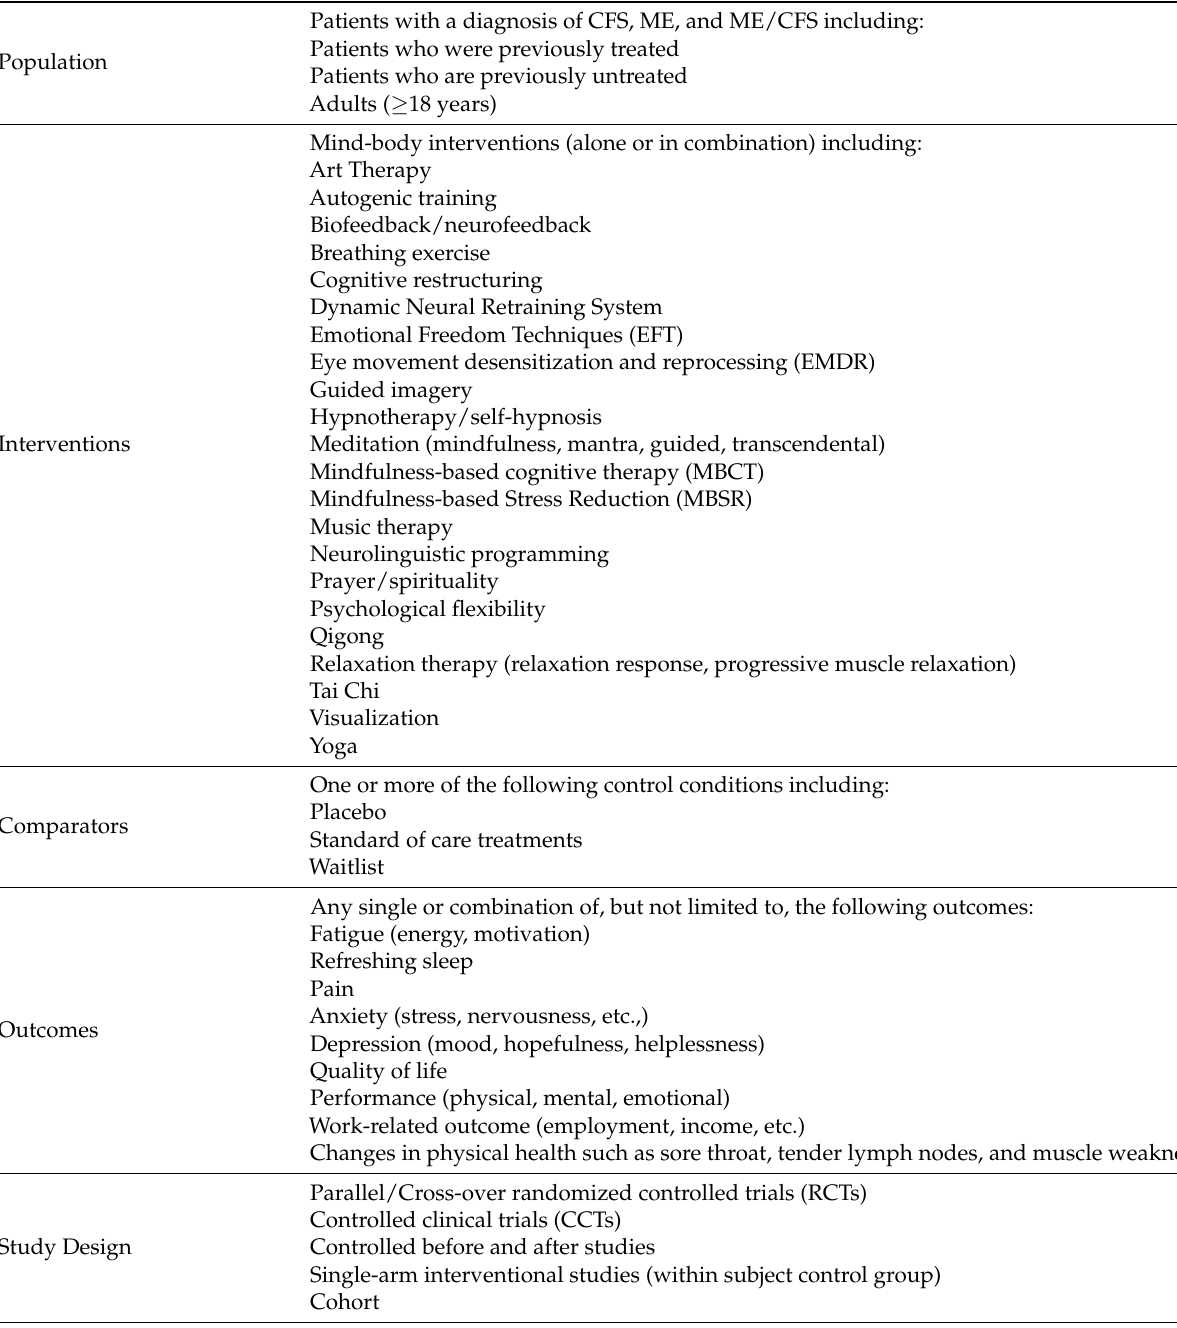
Table 1. Criteria for selecting